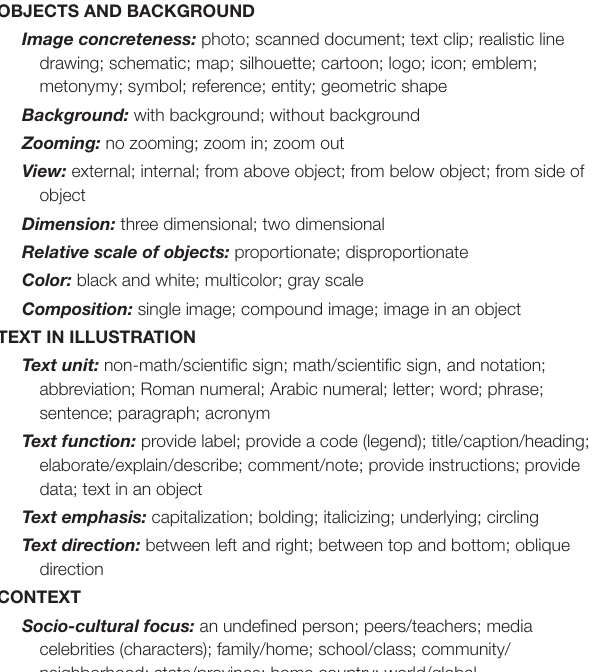
TABLE 2 | Segment of the list used to code non-textual components in different assessment programs. OBJECTS AND BACKGROUND